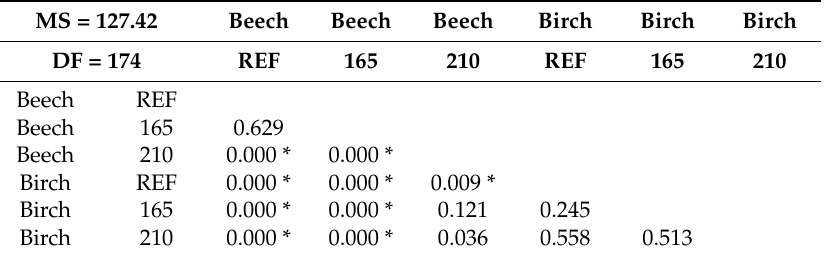
Table A8. Duncan’s Multiple Range Test for Hardness